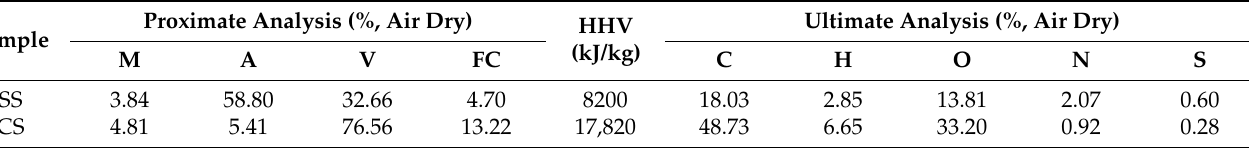
Table 4. Main characteristics of the employed SS and